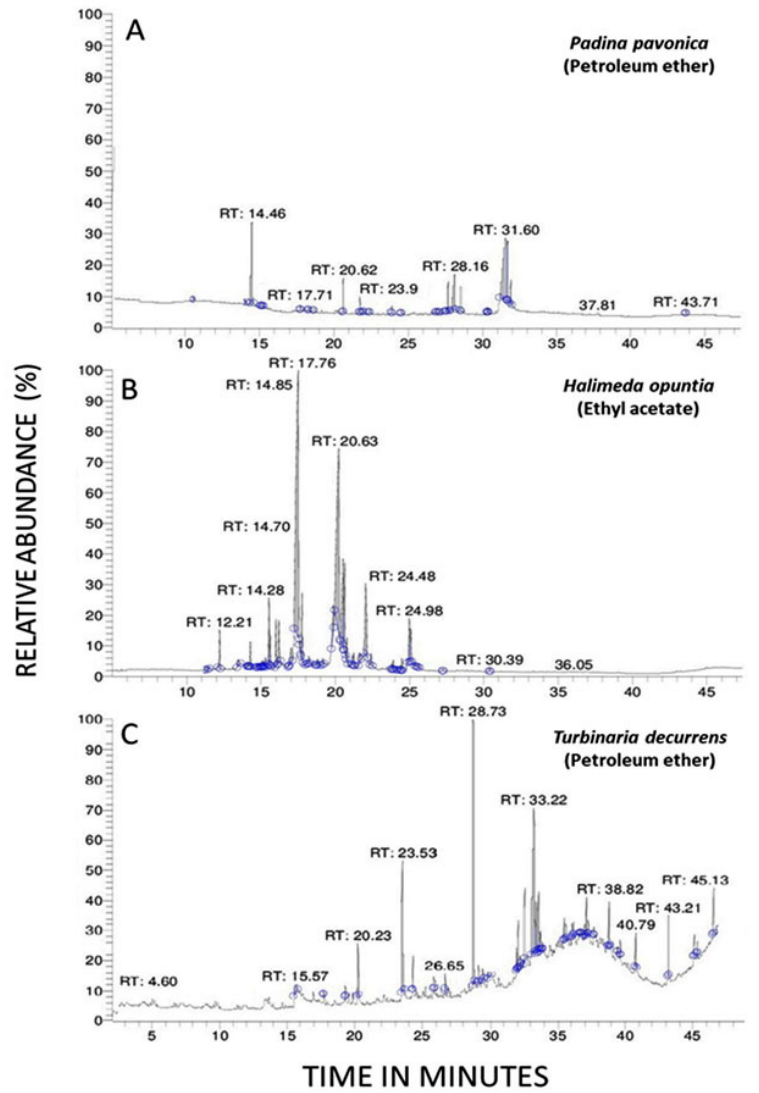
Fig. 5. GC-MS chromatogram analysis of the most effective extract constituents of algae; A) P. pavonica (extracted by petroleum ether), B) H. opuntia (extracted by ethyl acetate) and C) T. decurrens (extracted by petroleum ether). RT = Retention